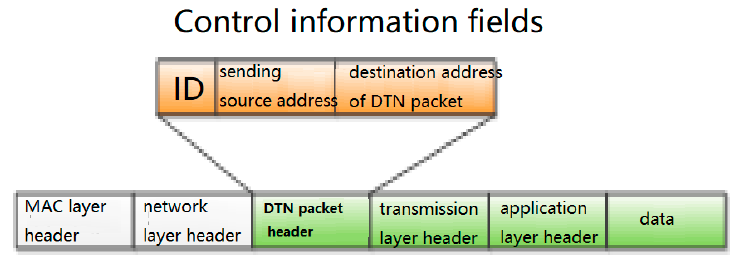
Figure 3. Packet format.